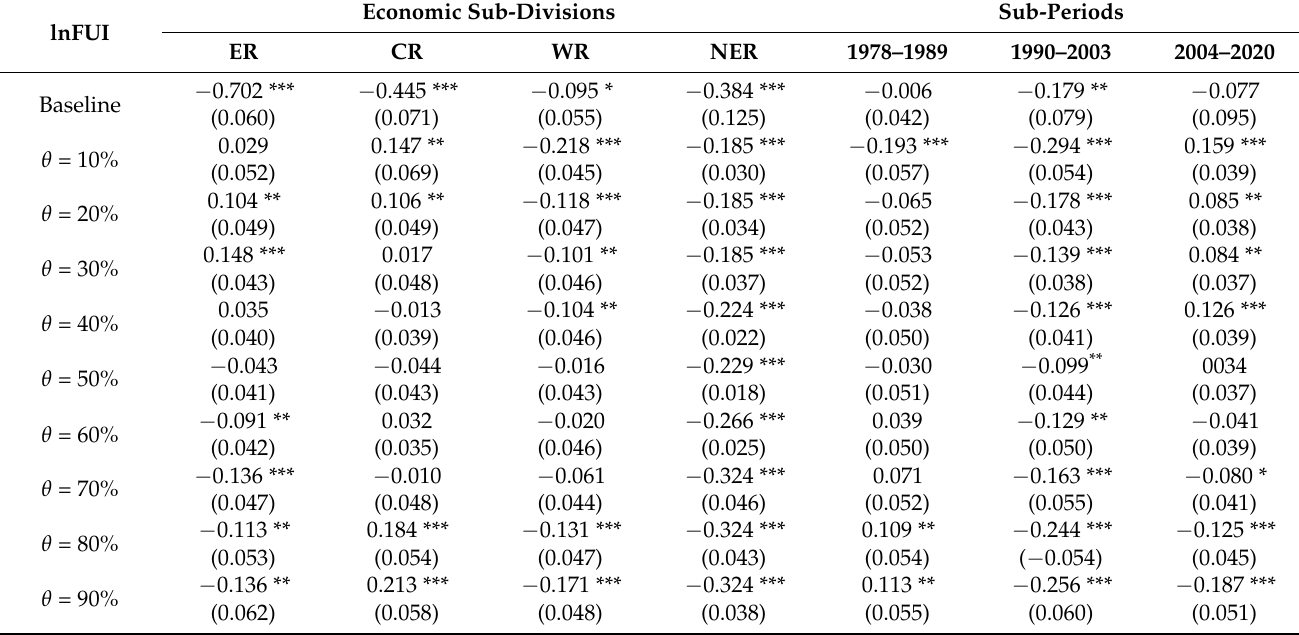
Table 5. Estimation results of QRM for the regional